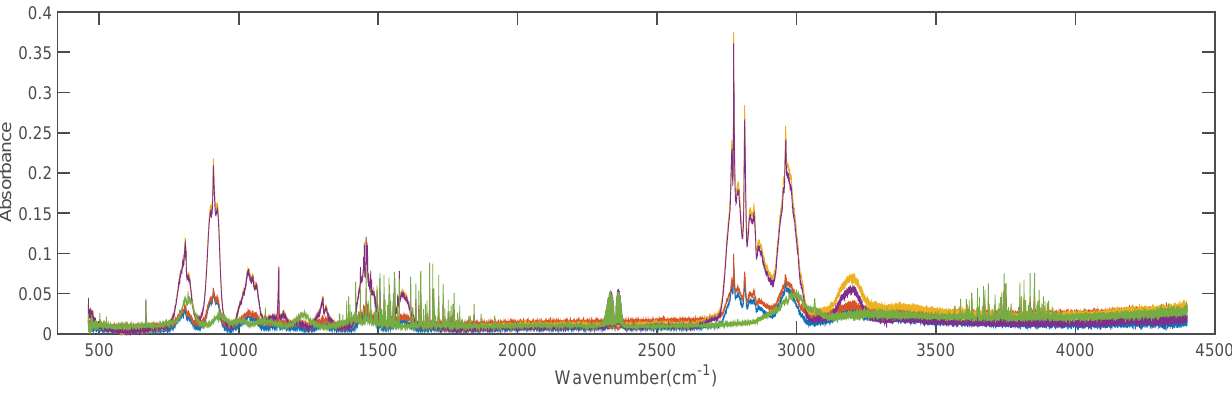
Figure 5. Five spectra of compound 1,1-dimethyl hydrazine with different concentrations in the EPA dataset.